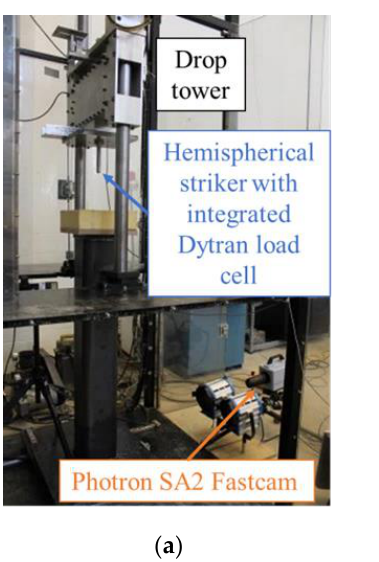
Figure 6. ( a ) Low-velocity ISO 6603-2 apparatus and ( b ) quasi-static puncture apparatus. Quasi-static puncture tests were completed on an electromechanical MTS load frame with a crosshead speed of 0.22 mm/s (0.005% of 4400 mm/s) as shown in Figure 6b. Dis- placement and strain fields on the specimen surface (100 mm diameter region inside of the clamping ring) opposite the 20 mm hemispherical indenter were acquired with a Cor- related Solutions digital image correlation (DIC) system running VIC 3D software. Two Point Grey Grasshopper GRAS-50S5M cameras were triggered with a transistor-to-tran- sistor logic (TTL) signal from the load frame to a NI USB-6221BNC data acquisition device which activated/deactivated the DIC system at the beginning/end of the prescribed cross- head displacement.